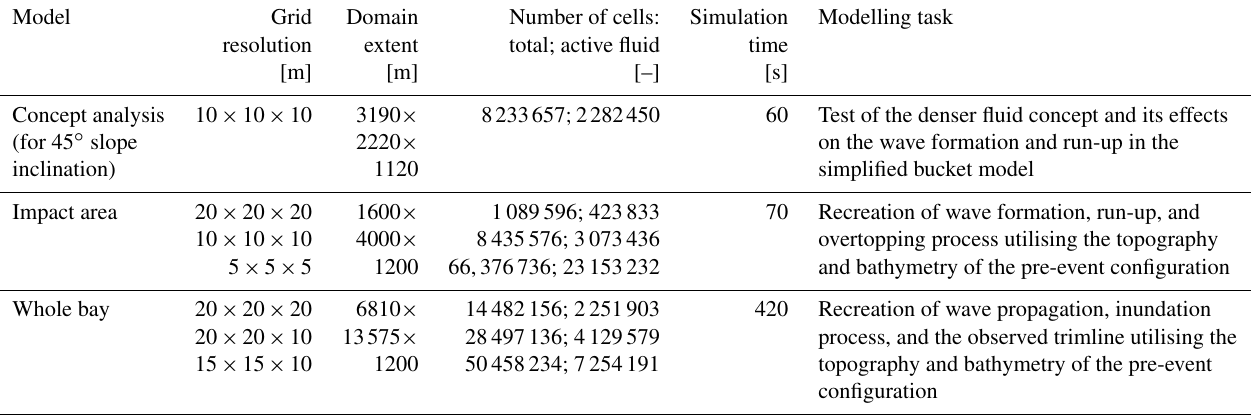
Table 2. Summary of the simulation setup and modelling